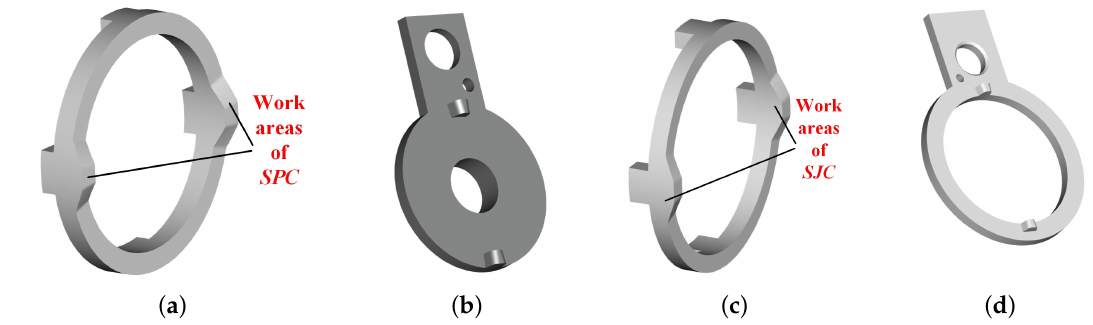
Figure 5. The cam components. ( a , b ) SPC and SPF cam components. ( c , d ) SJC and SJF cam